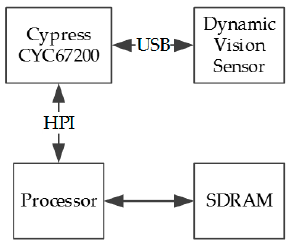
Figure 2. Events reception system block diagram.